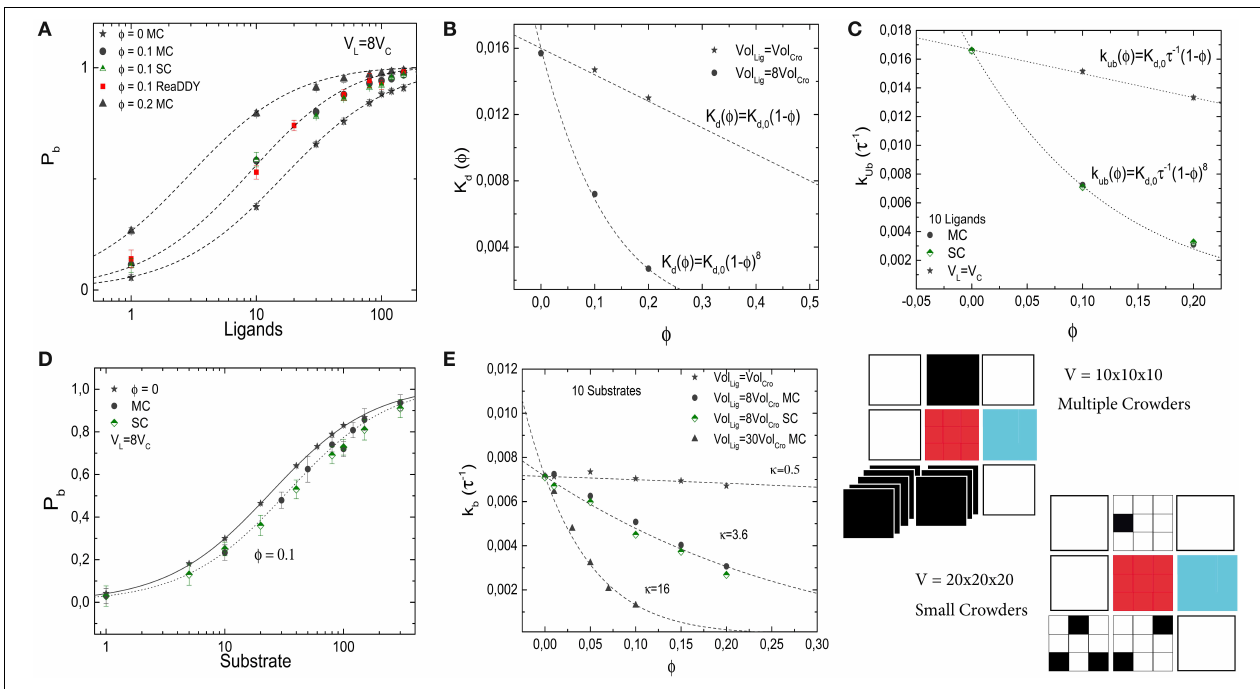
FIGURE 7 | Effects of crowder size on the binding of a ligand to a receptor (A–C) and on the diffusion-limited enzymatic reaction (D,E). In all panels, gray-filled symbols represent the implementation in which multiple crowders can occupy the same lattice site (MC), half-filled symbols (green and pink) represent the implementation of the small crowders (SC) and the red symbols show results from ReaDDy. In general, good agreement between the methods is observed. (A) P b of the simple binding reaction as a function of the number of ligands for different crowder sizes and volume